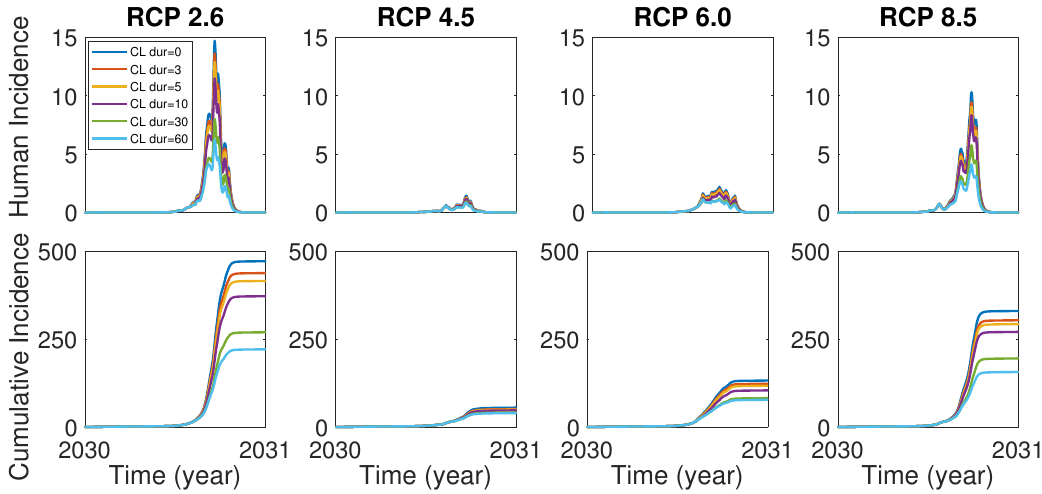
Figure 5. The effect of the park closure (CL) for duration 0, 3, 5, 10, 30 and 60 days on human incidence ( top ) and cumulative human incidence ( bottom ). Park closure for duration 0 means there is no park